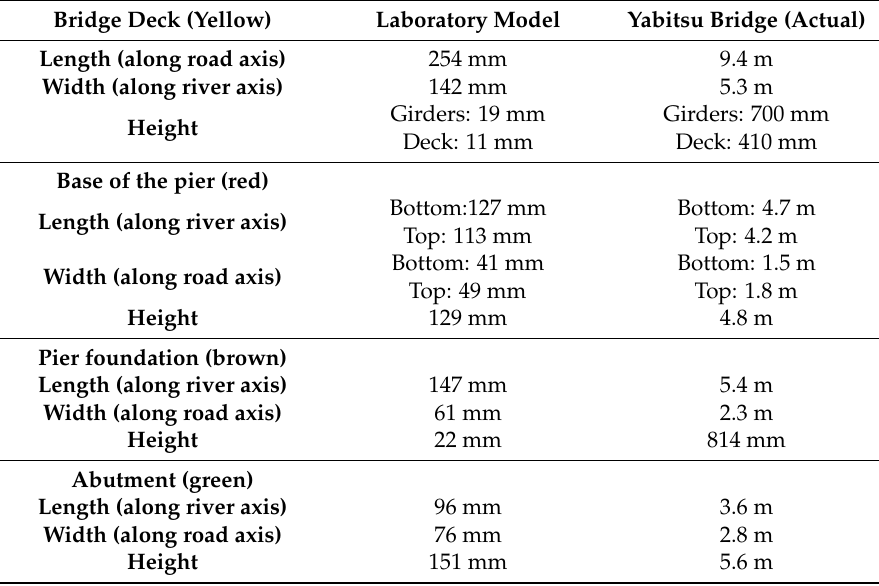
Table 1. Dimensions of the scale bridge model (Colors refer to Figure